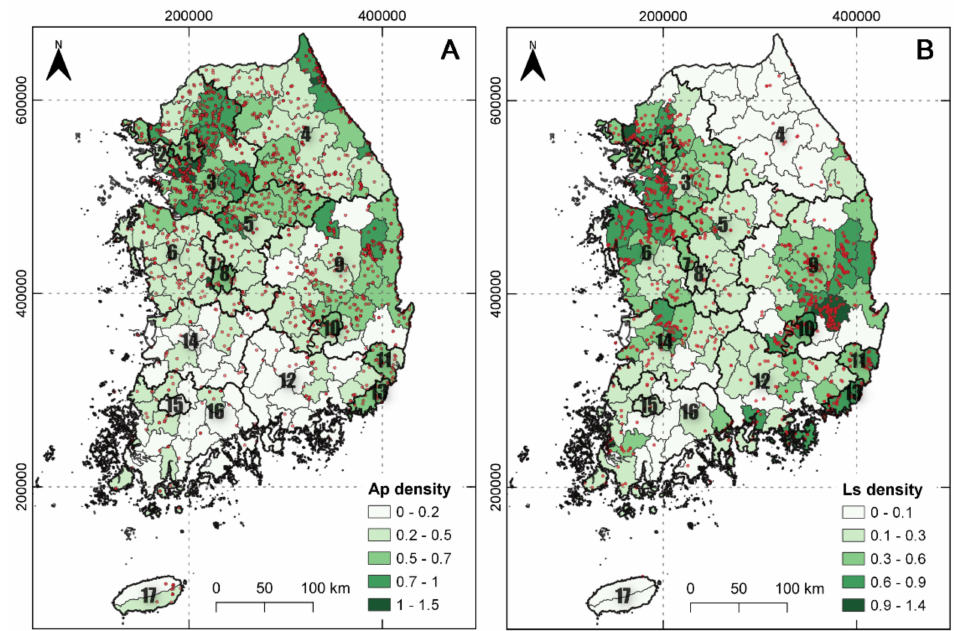
Figure 1. The density of A. pilosus (Ap) ( A ) and L. scariola (Ls) ( B ) in 165 districts (small polygons) in South Korea. The bold numbers in the polygons represent the 17 provinces of South Korea. The red points represent the points at which the two plant species were detected. The legends show log-transformed A. pilosus and L. scariola population